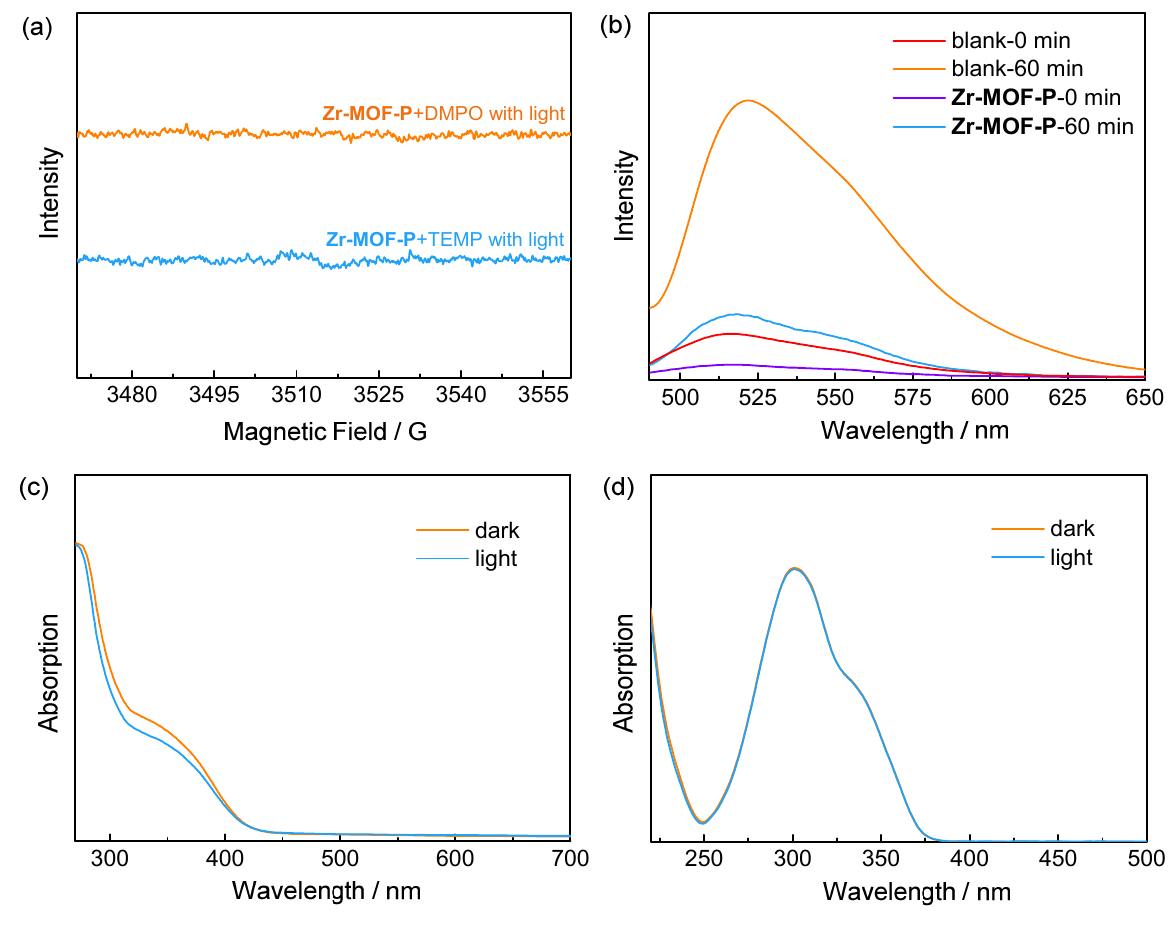
Figure 5. ( a ) EPR spectra of Zr-MOF-P using TEMP and DMPO as trapping agents under irradiation. ( b ) Fluorescence spectra of Singlet Oxygen Sensor Green in the suspension of Zr-MOF-P with and without illumination ( λ ex = 480 nm). ( c ) UV–Vis spectra of nitrotetrazolium blue chloride in the suspension of Zr-MOF-P with and without illumination. ( d ) UV–Vis spectra of coumarin-3-carboxylic acid in the suspension of Zr-MOF-P with and without illumination.